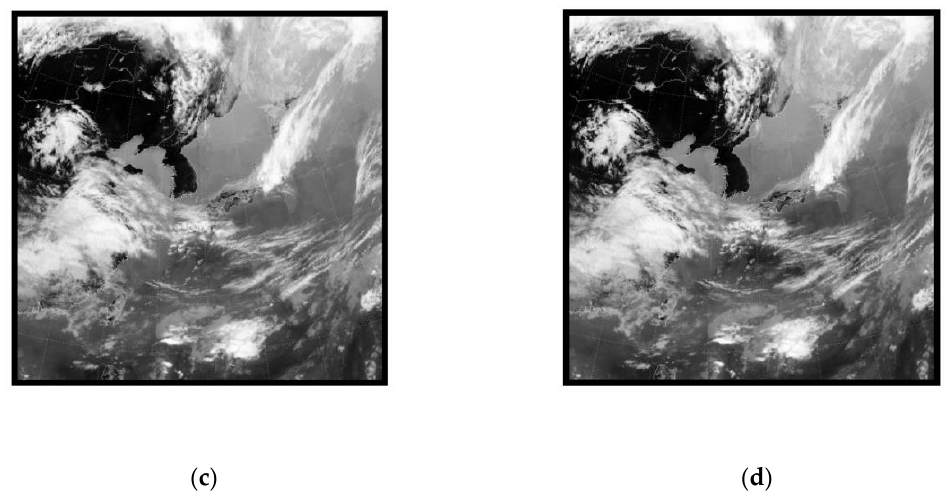
Figure 2. ( a ) Midwave infrared (MWIR) reflectance, ( b ) water vapor (WV) radiance, ( c ) IR1 radiance, and ( d ) IR2 radiance observed from COMS / MI on 1 May 2017, 04:00 UTC (13:00 KST, daytime).